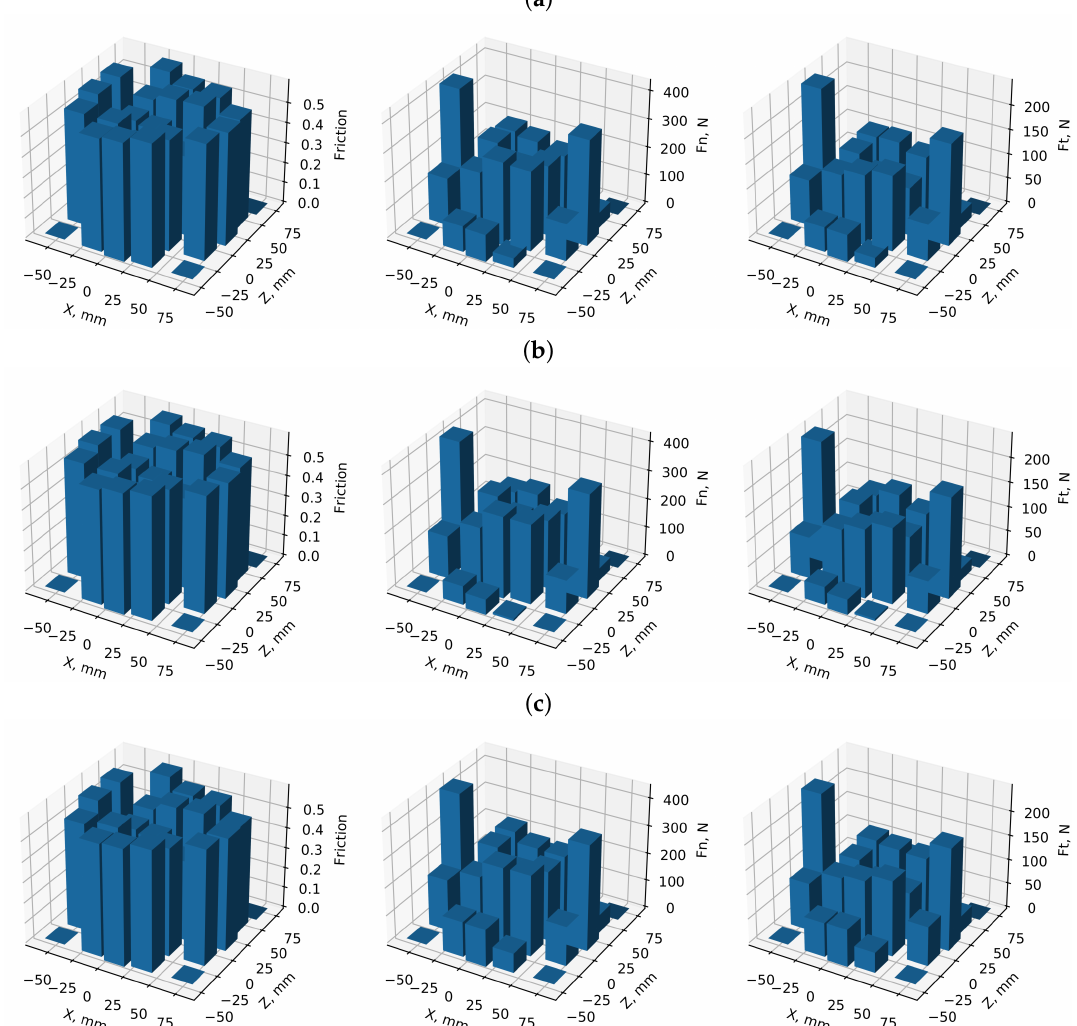
Figure 8. Friction µ z , normal F n and tangential F tz force distribution on the tyre–asphalt interface for pressures 0.2 ( a ), 0.18 ( b ) and 0.22 ( c ) MPa under a ∼ 4 kN